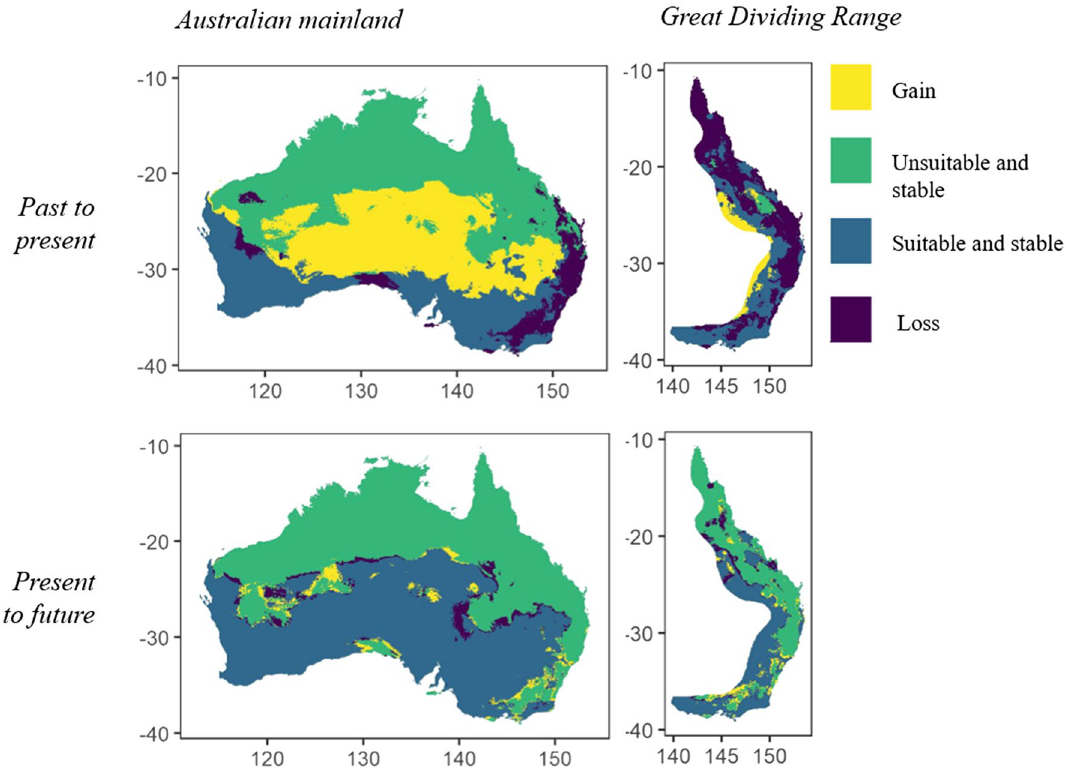
Figure 4. Predicted distribution change from ensemble models, across Australia and the Great Dividing Range region, past to present and present to future. The figures were generated in R (version 3.6.0, https ://www.r-proje